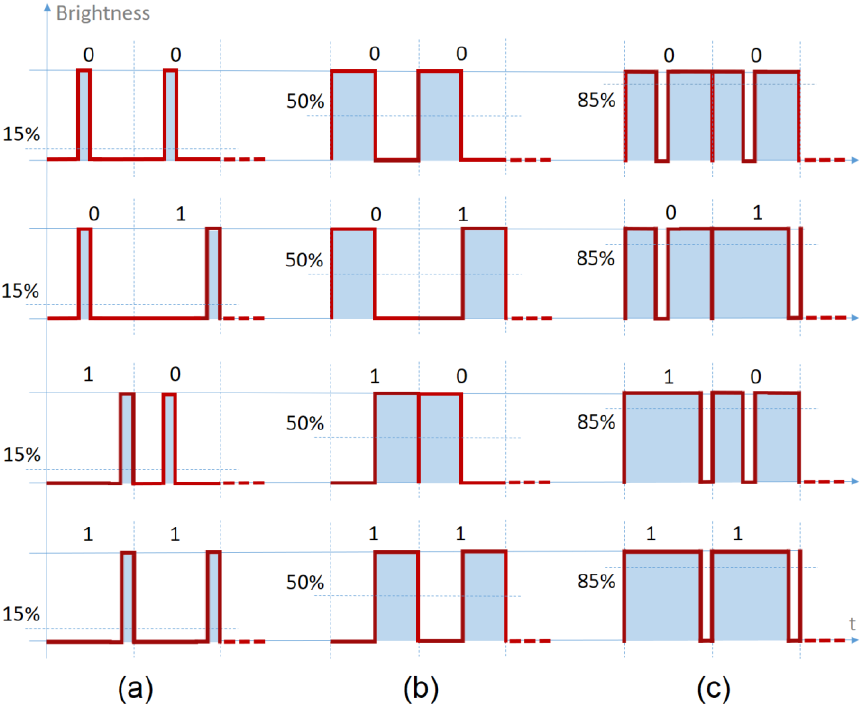
Figure 1. The modified VPPM coding scheme implemented in [34]: ( a ) Average illumination less than 50%; ( b ) Average illumination equal to 50%, the same as Manchester coding; ( c ) Average illumination greater than 50%.